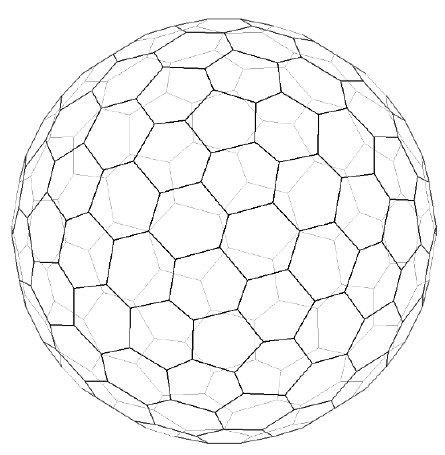
Figure 1 . A cartoon of the e(cid:11)ective model of the light-cone Schwarzschild black hole. The cells represent Planck size marginally bound D0 branes, about d per cell in d space dimensions. The cells are glued together with a condensate of o(cid:11)-diagonal matrix modes that act as sca(cid:11)olding and do not carry information or